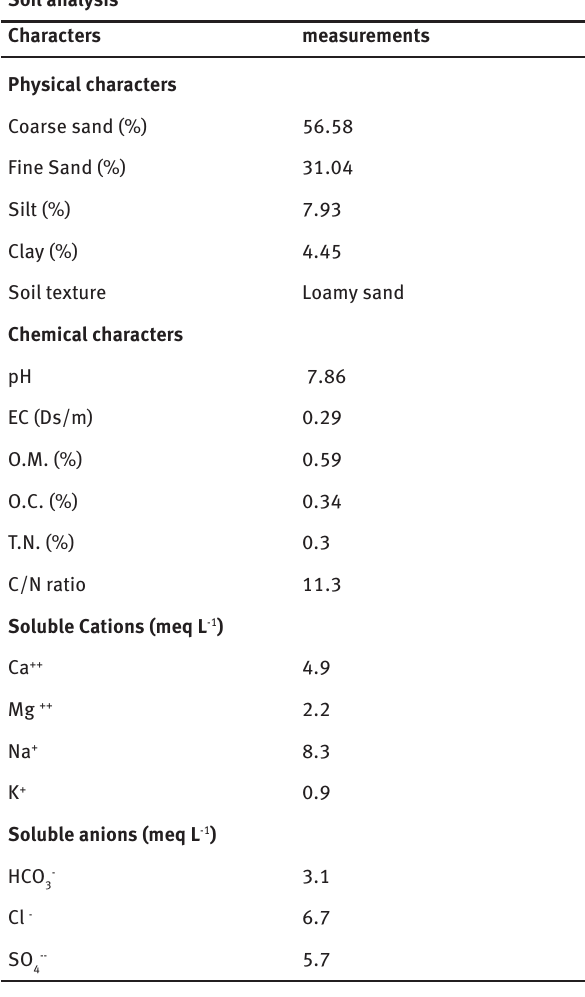
Table 1: Physical and chemical characters of soil used in the current study in a field